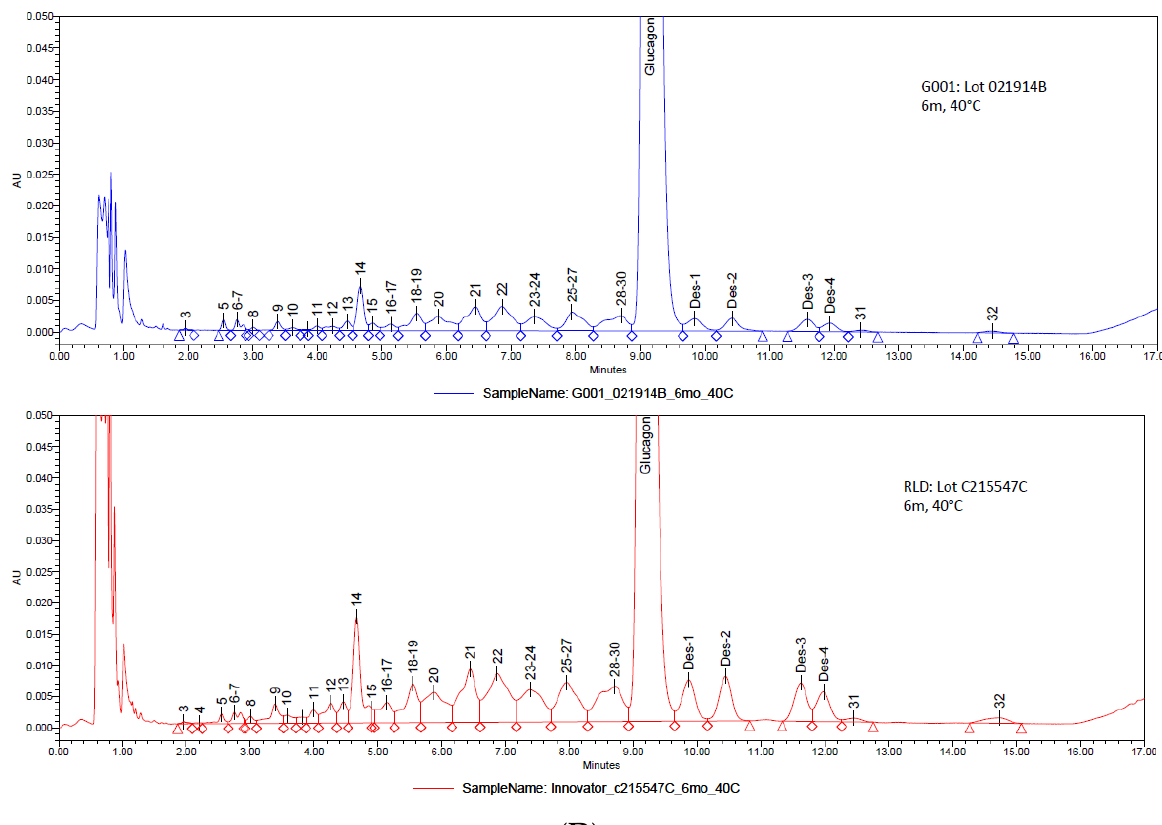
Figure 2. G001 = AMP-glucagon; RLD = ELI-glucagon. ( A ). Representative chromatograms at zero time, 25 ◦ C. ( B ). Representative chromatograms at 6 months, 25 ◦ C. ( C ). Representative chromatograms at 24 months, 25 ◦ C. ( D ). Representative chromatograms at 6 months, 40 ◦ C.